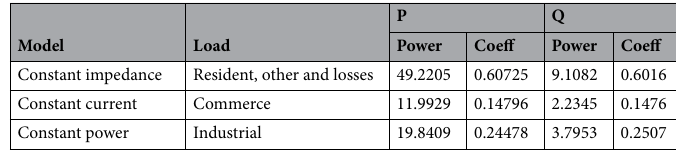
Table 3. Pascuales ZIP static load model coefficients and Voltage bus